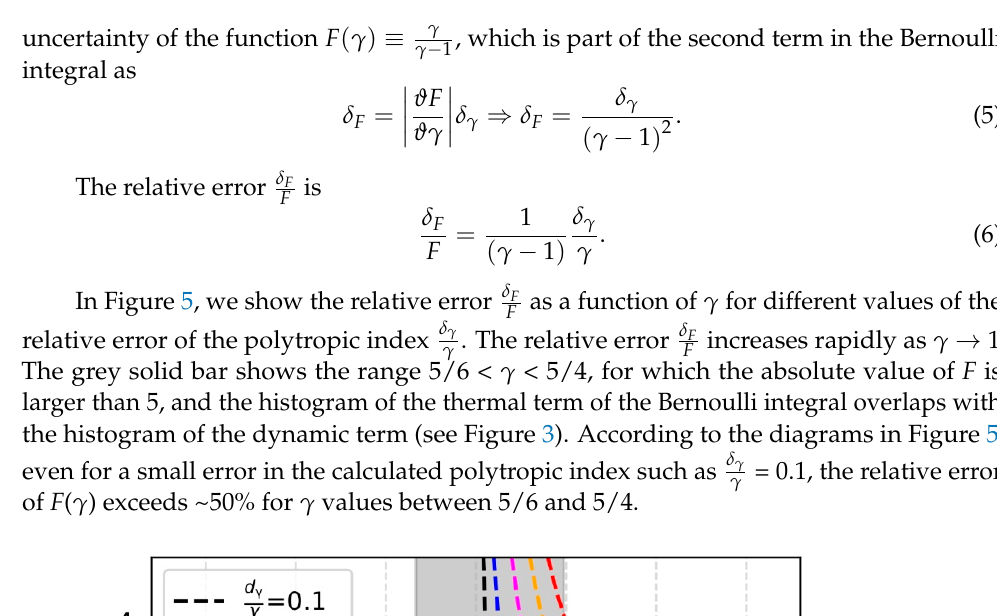
, as a function of γ and for polytropic index γ − 1 , as a function of 𝛾 and for polytropic index (cid:3082)(cid:2879)(cid:2869)